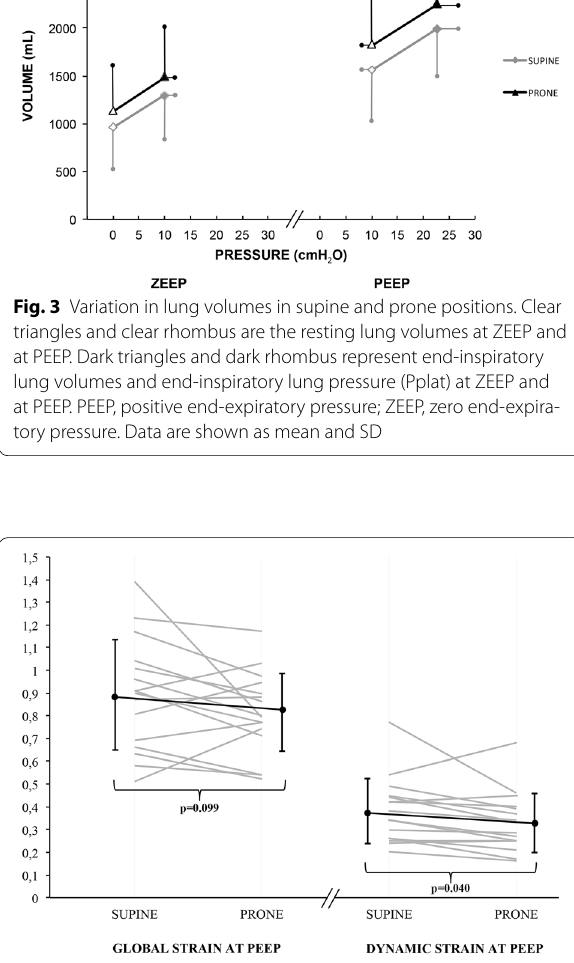
Fig. 4 Variation of individual values of global and dynamic strain at PEEP with the change of position. Dark lines represent mean and SD. PEEP, positive end‑expiratory